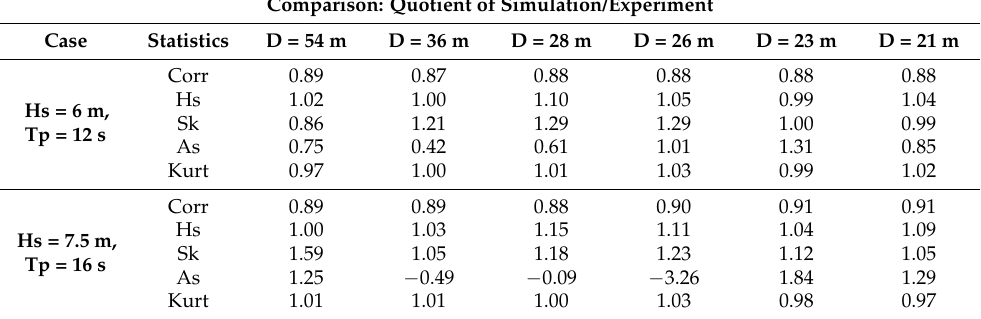
Table 1. Comparison between experiment and simulations at 6 positions: the correlation ‘Corr’ of the time traces and the quotients of statistical quantities of simulation and measurement for: ‘Hs’ significant wave height, ‘Sk’ skewness, ‘As’ Asymmetry, and ‘Kurt’ Kurtosis for the two wave cases H6T12 and